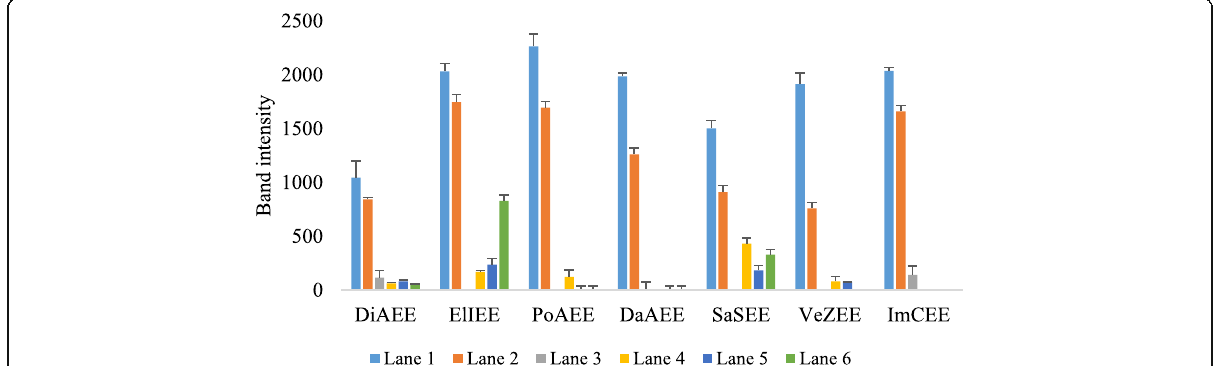
Fig. 5 Band intensity graph of DNA protecting activity. (Lane 1: Control genomic DNA; Lane 2: Fenton ’ s reagent + DNA; Lane 3: Fenton ’ s reagent + DNA + Quercetin; Lane 4: Fenton ’ s reagent + DNA + 2 μ l plant extract; Lane 5: Fenton ’ s reagent + DNA + 4 μ l plant extract; Lane 6: Fenton ’ s reagent + DNA + 6 μ l plant